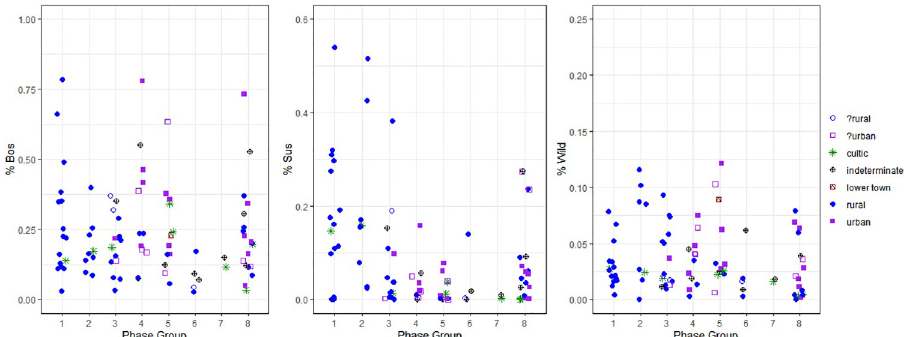
Fig 3. Stripcharts indicating the proportional representation of wild taxa as well as of cattle and pigs within domesticates for each phase.